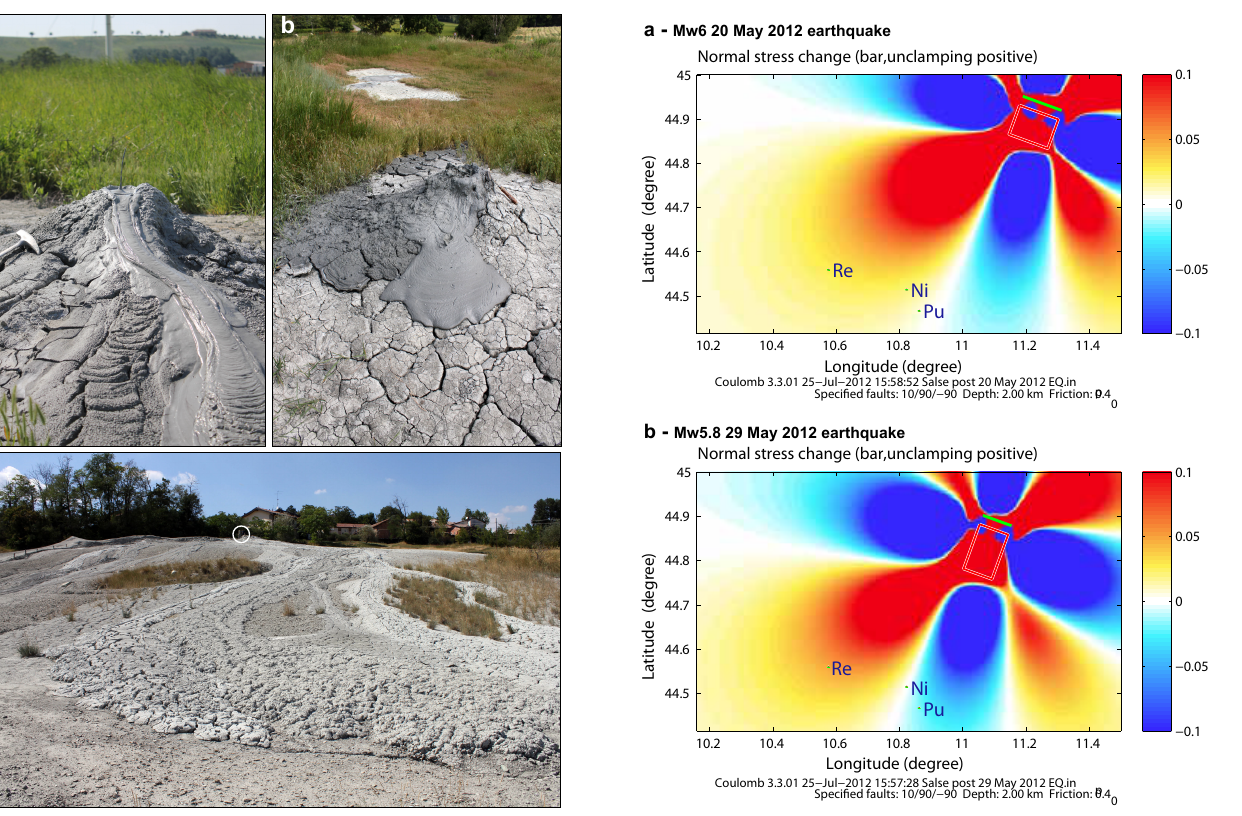
Fig. 6. Computed changes in normal stresses (unclamping posi- tive, clamping negative) produced by the 20 May and 29 May 2012 Figure 6: Computed changes in normal stresses (unclamping positive, clamping 675 earthquakes (panels a and b , respectively). Stresses are computed negative) produced by the 20 May and 29 May, 2012 earthquakes (panels a and b, 676 o on N10 ◦ E-oriented mud dikes. After the 20 May event, discharge respectively). Stresses are computed on N10 E oriented mud dikes. After the 20 May 677 event, discharge increased at all three mud volcanoes considered here (Re, Regnano; 678 increased at all three mud volcanoes considered here (Re, Regnano; Ni, Nirano; Pu, Puianello). The computed stresses favor unclamping of dikes at all 679 Ni, Nirano; Pu, Puianello). The computed stresses favor unclamp- three locations. After the 29 May event, discharge increased at Regnano, and activity 680 ing of dikes at all three locations. After the 29 May event, discharge was reduced at the other two mud volcanoes, consistent with the stress changes 681 increased at Regnano, and activity was reduced at the other two induced by the earthquake. 682 mud volcanoes, consistent with the stress changes induced by the 683